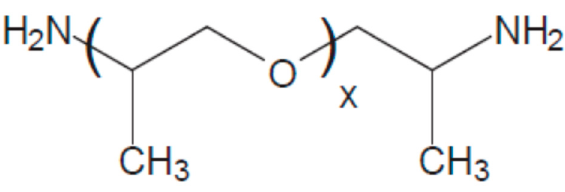
Figure 2. Characteristic structure of JEFFAMINE D-230 (x ≈ 2.5) and JEFFAMINE D-2000 (x ≈ 30).